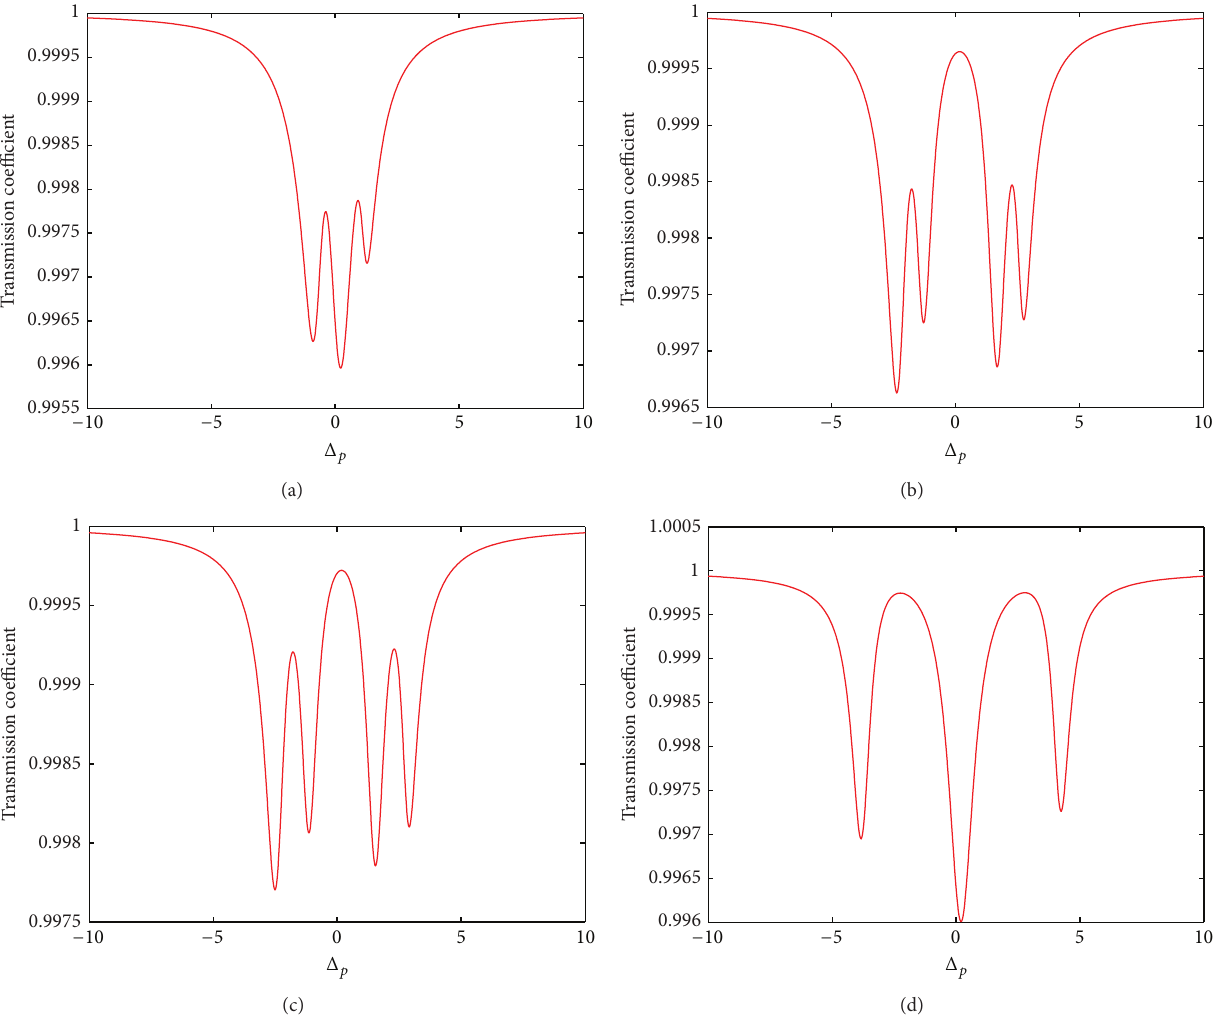
Figure 3: Transmission coefficient versus probe field detuning. The selected parameters are (a) 𝑇 1 = 𝑇 2 = 0.5 meV; (b) 𝑇 1 = 2 meV, 𝑇 2 = = 0.5 meV, 𝑇 = 2 meV; (d) 𝑇 = 𝑇 = 2 meV. The other parameters are the same as in Figure 0.5 meV; (c) 𝑇 1 2 1 2